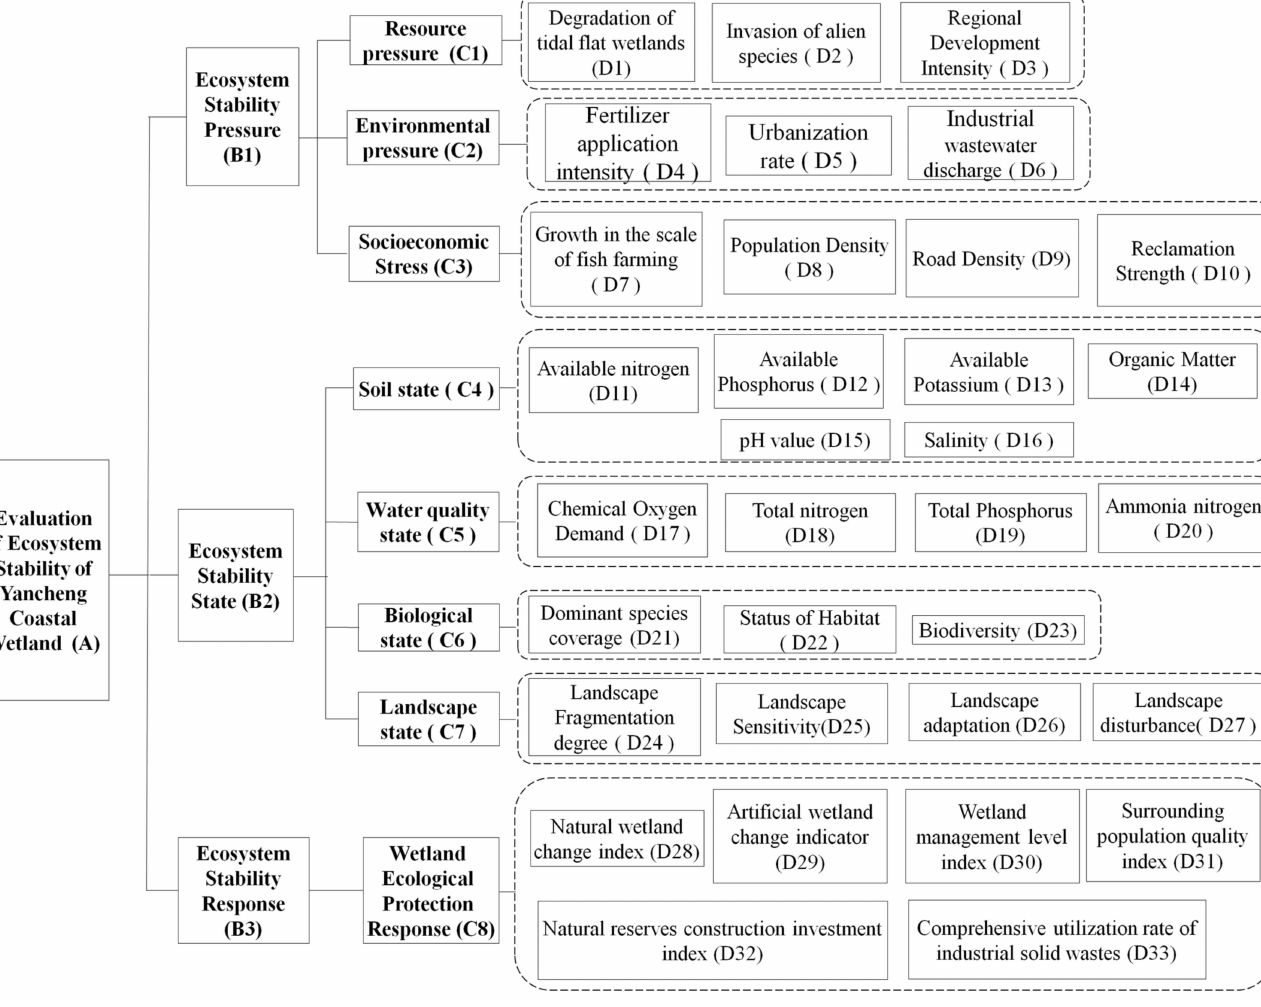
Figure 3. The ecosystem stability evaluation index system of Yancheng coastal